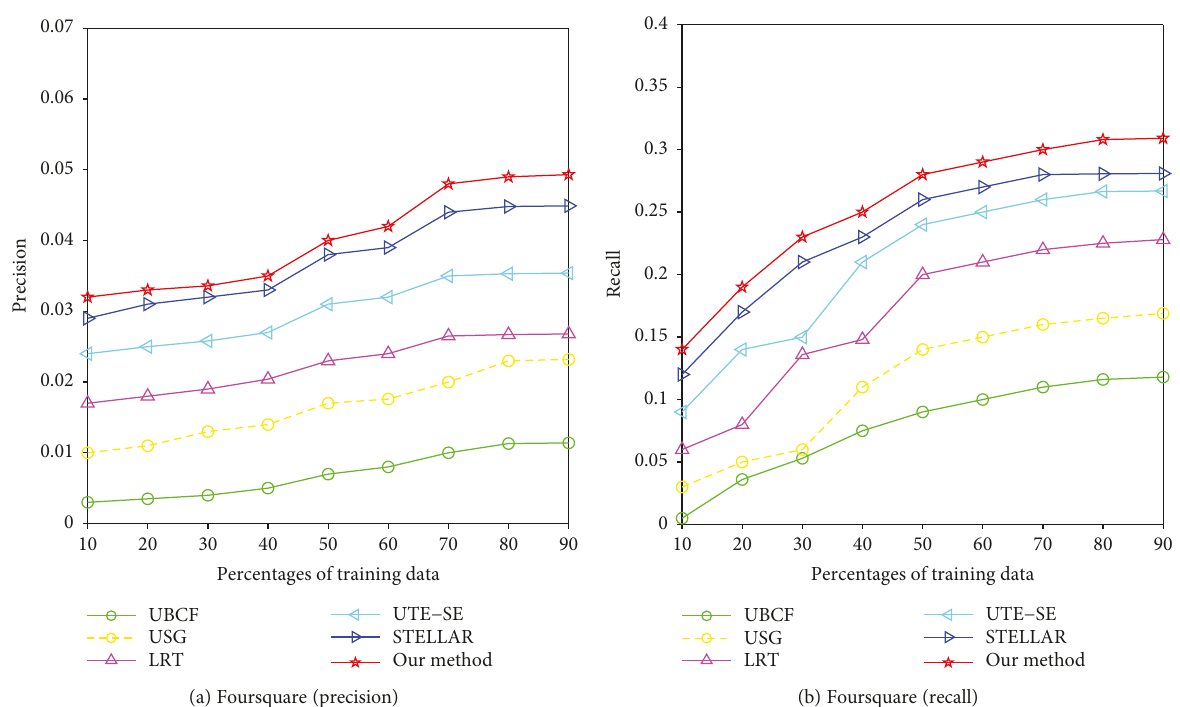
Figure 7: E ff ect of percentages of training data on the Foursquare